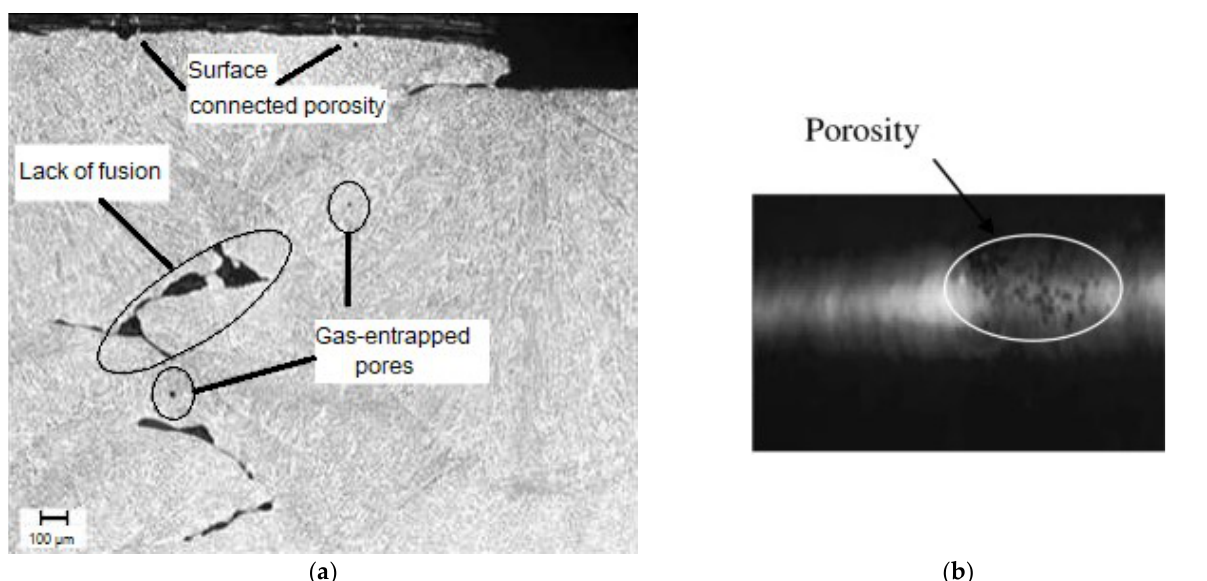
Figure 1. Examples of porosity: ( a ) Stainless steel piece produced using additive manufacturing indicating the presence of pores (on surface and inside the part) and lack of fusion, adapted from [3]. ( b ) Pores in a weld bead identified with an X-ray test, adapted from [4].